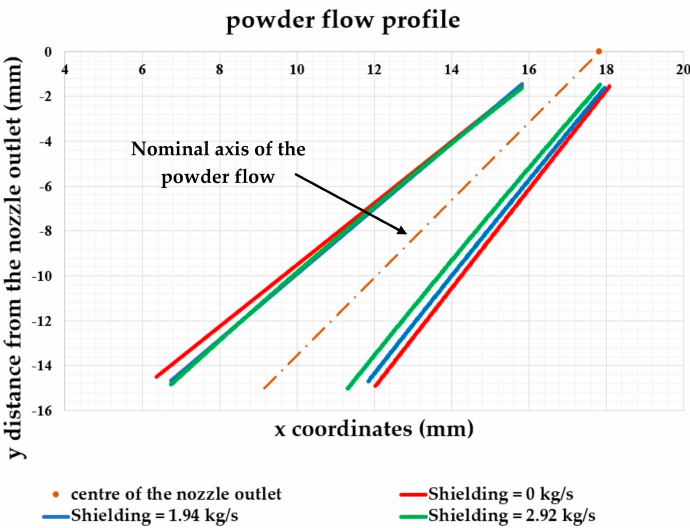
Figure 7. Influence of the shielding gas on the profile of the powder flow (one active